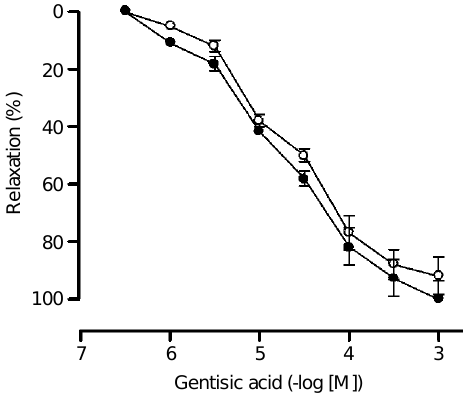
Figure 1 - Mean relaxant con- centration-response curves for gentisic acid in the guinea pig isolated trachea, without (filled circles) or with (open circles) epi- thelium. Data are reported as means ± SEM of 10 experi- ments. P<0.05 for the difference between points (Student t